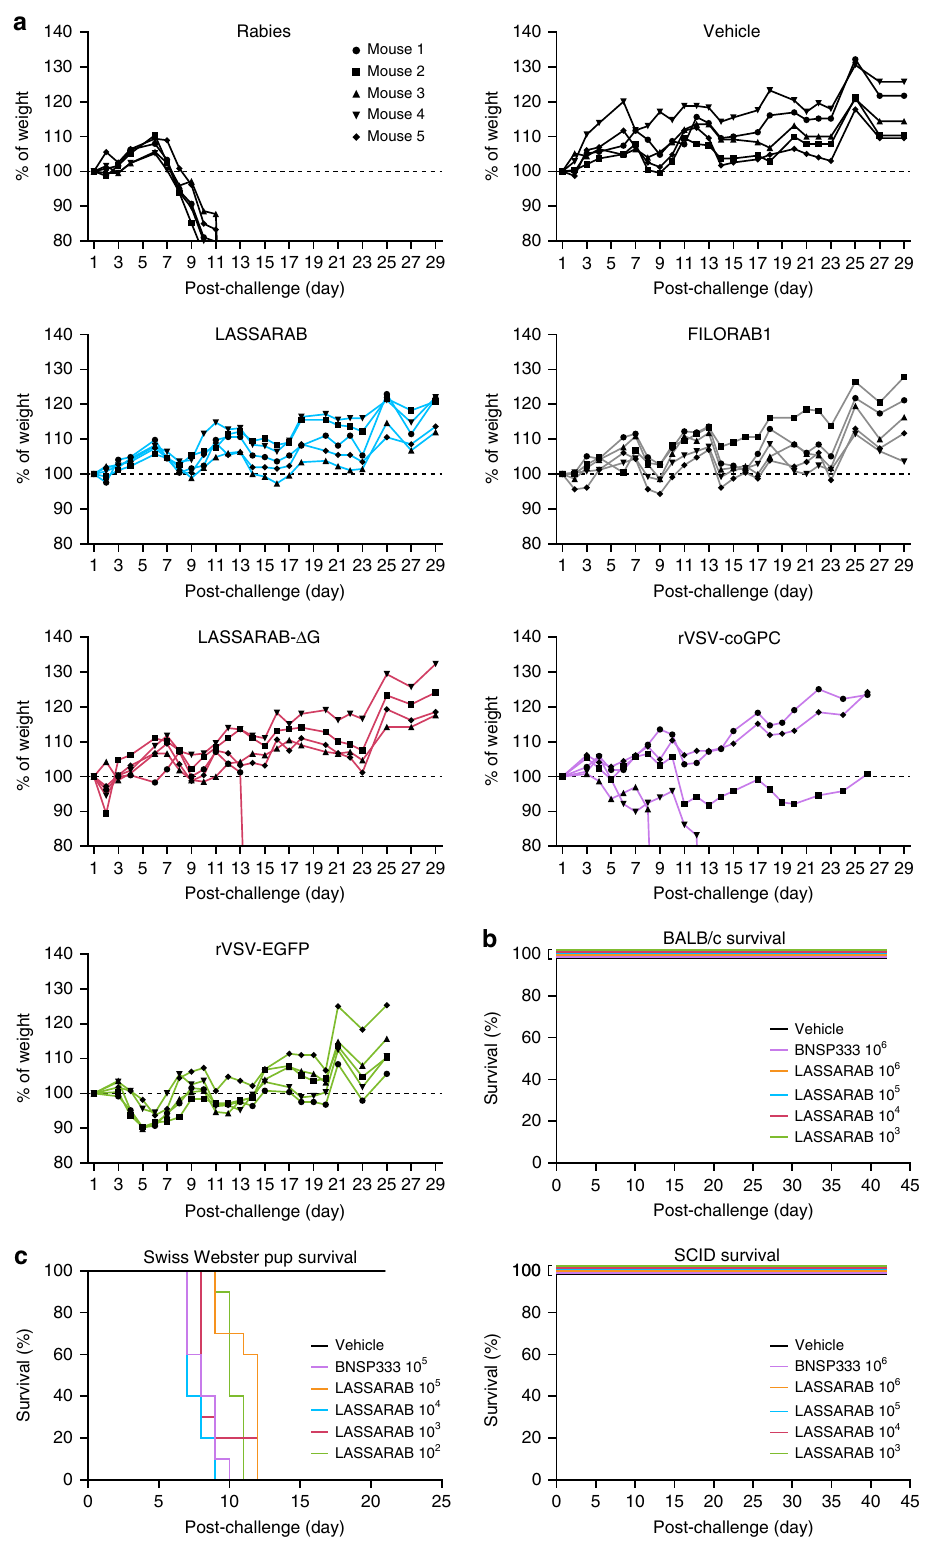
rc-LASSARAB- Δ G immunized mice only, and only at low titers on days 28 and 42 (Supplementary Fig. 2). rVSV-GPC had a signi fi cant LASV GPC-speci fi c immune response (Fig. 4c, purple